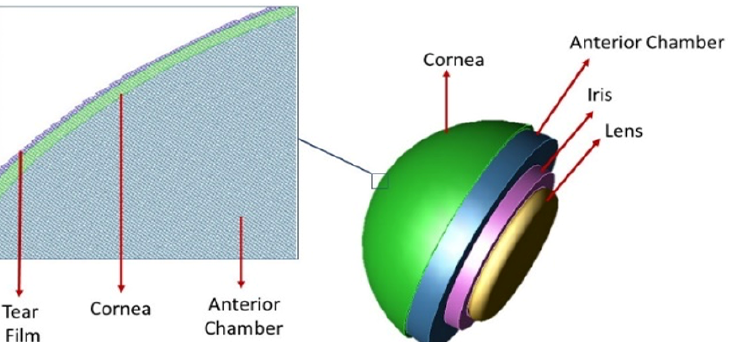
Figure 3. The model’s mesh cutplane illustrates the meshing priority; the tear film and the cornea have higher meshing priority than the aqueous humor in the anterior